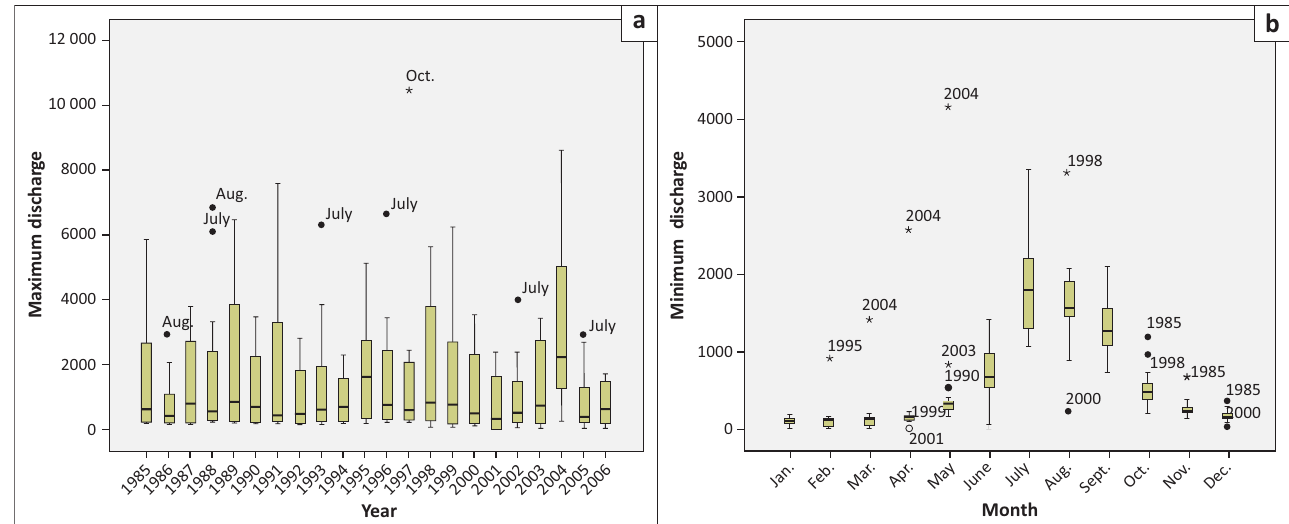
FIGURE 5: Box plot of year-wise recorded (a) maximum discharge and (b) minimum discharge at Kaunia station from 1985 to